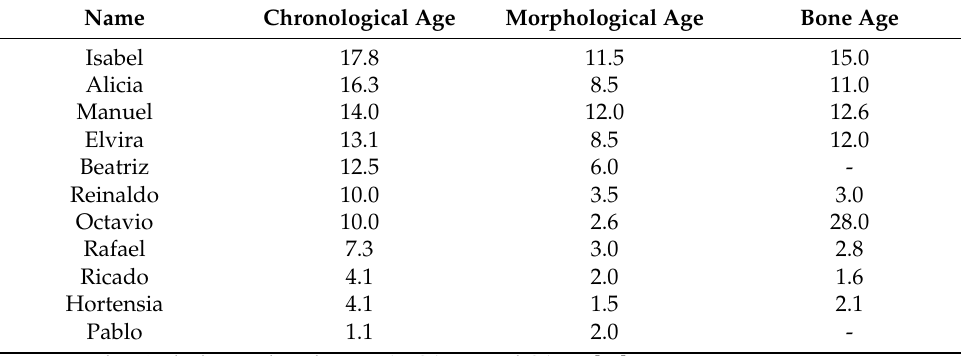
Table 1. Sizes and ages of a family displaced by political